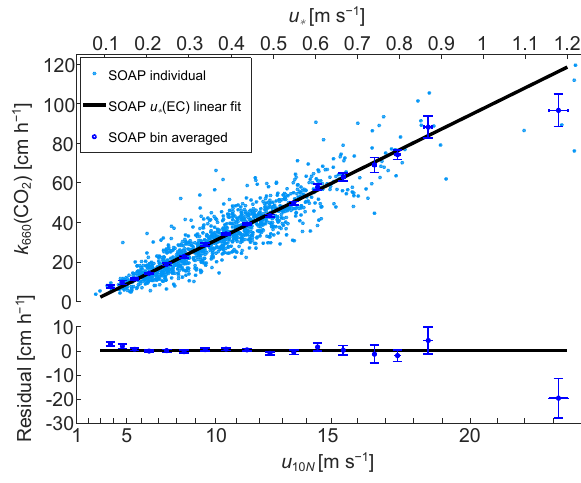
Figure 8. Top: CO 2 gas transfer velocity normalised to Sc = 660 as a function of u ∗ . The data are shown as individual measurements (light blue) and bin averaged over 1ms − 1 wind-speed bins (dark blue) (the width of the last two bins was increased to 3ms − 1 in order to account for the scarcity of the data at high wind speeds). The error bars indicate the standard deviation. The linear regression to the individual data (Eq. 10) is shown as a black line. Bottom: residual difference of the bin averages from Eq. (10). The two x axes show the friction velocity and the corresponding u 10N when the COARE 3.5 drag coefficient is